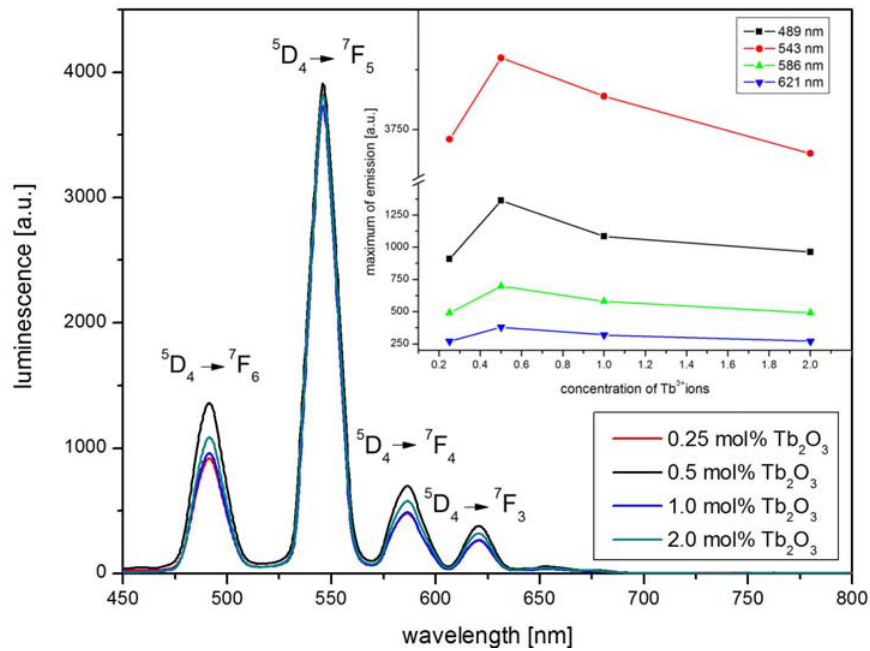
Figure 2. The emission spectra of phosphate glasses doped with (0.25, 0.5, 1, 2) mol% Tb O . (the inset) The maximum intensity of luminescence as a function of 2 3 terbium